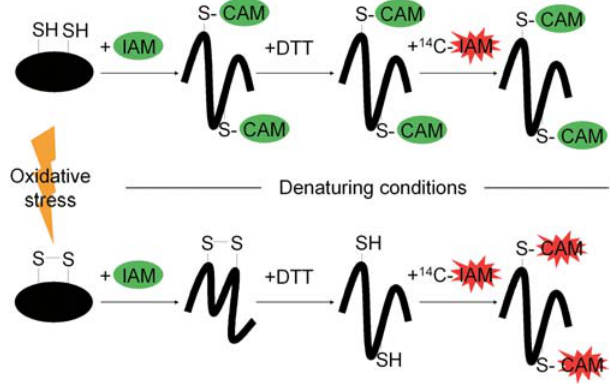
Figure 1. Schematic Overview of Our Differential Thiol-Trapping Technique Under normal growth conditions (top), a hypothetical cytoplasmic protein present within the complex mixture of the crude whole-cell extract is fully reduced. Upon incubation in TCA, all thiol-disulfide exchange reactions are quenched and the cells lyse. In the first thiol- trapping step, the protein is denatured and incubated with IAM. Accessible thiol groups are quickly carbamidomethylated (CAM) and blocked for the subsequent reduction/alkylation steps. After TCA precipitation and washing, DTT is added to reduce oxidized cysteines, and 14 C-labeled IAM is used to modify potentially newly released, accessible cysteines. Under oxidative stress conditions (bottom) the cysteine residues become modified (e.g., sulfenic acid and disulfide bonds). In the first trapping step, IAM cannot attack the oxidized disulfide bond. Only after reduction with DTT are the cysteines accessible to the 14 C- labeled IAM. Therefore, the 14 C radioactivity correlates with the degree of thiol modification in the protein. The differentially trapped protein species are chemically identical regardless of their original thiol-disulfide status. This ensures their identical migration behavior on 2D gel electrophoresis. DOI: